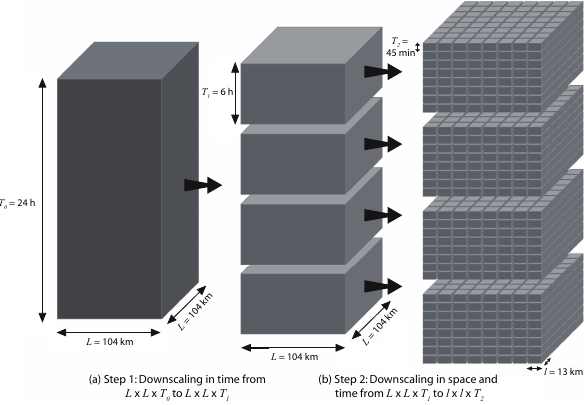
(b) Step 2: Downscaling in space and (a) Step 1: Downscaling in time from time from L x L x T 1 to l x l x T 2 L x L x T 0 to L x L x T 1 Fig. 4. Schematic of the precipitation downscaling tool based on STRAIN model. The procedure consists of two steps: (a) disaggre- gation in the time domain from the coarse scale L × L × T 0 ( L = Fig. 4. Schematic of the precipitation downscaling toolbased on STRAIN model. The procedure 6 104km, T 0 = 24h) to the fine scale L × L × T 1 ( T 1 = 6h); and (b) disaggregation in the space–time domain from the coarse scale consists of two steps: (a) disaggregation in the time domain from the coarse scale L x L x T 0 ( L = 7 L × L × T 1 to the fine scale l × l × T 2 ( l = 13km, T 2 = 45min). 104 km, T 0 = 24 h) to the fine scale L x L x T 1 ( T 1 = 6 h); and (b) disaggregation in the space-8 time domain from the coarse scale L x L x T 1 to the fine scale l x l x T 2 ( l = 13 km, T 2 = 45 min). 9 fall intensity R (mm h − 1 )